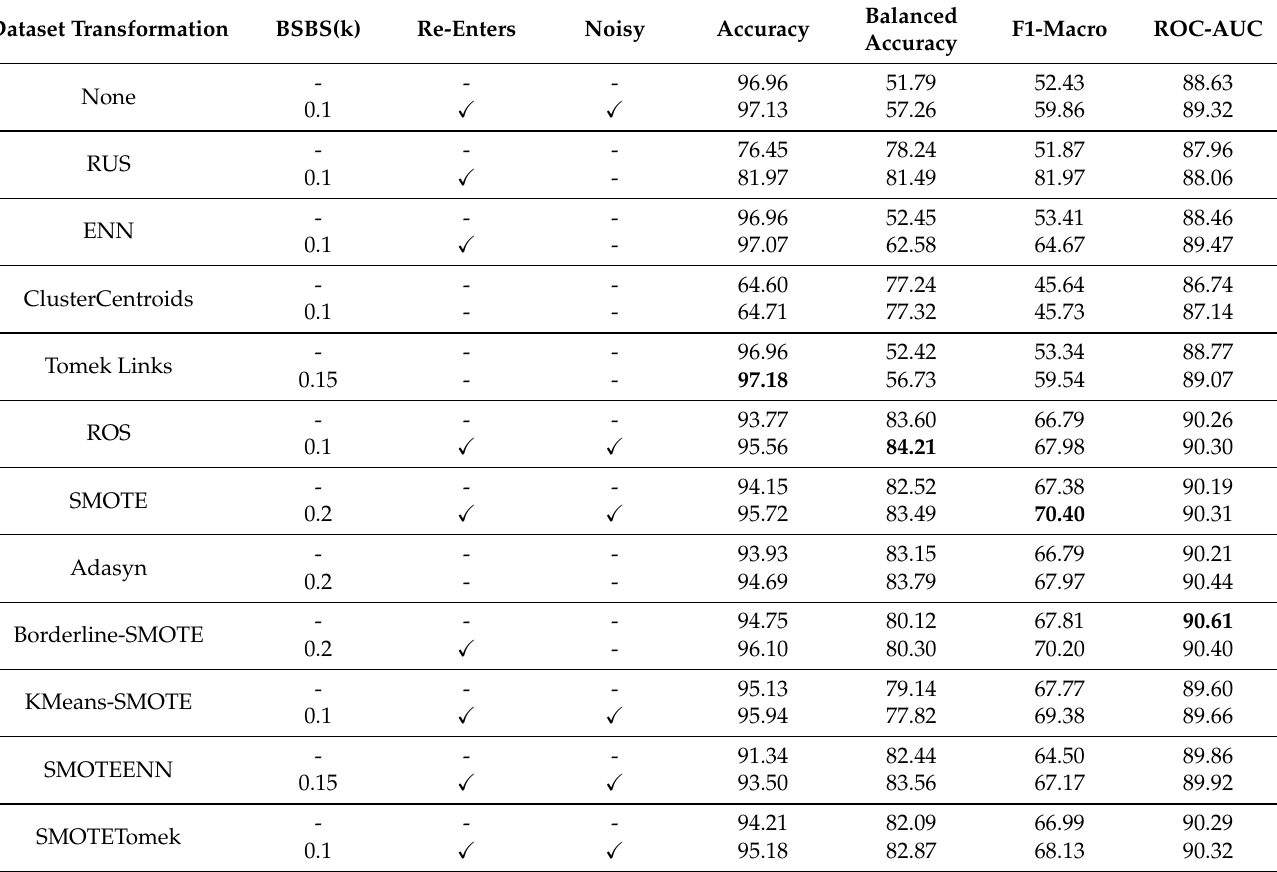
Table 3. Results for the ozone